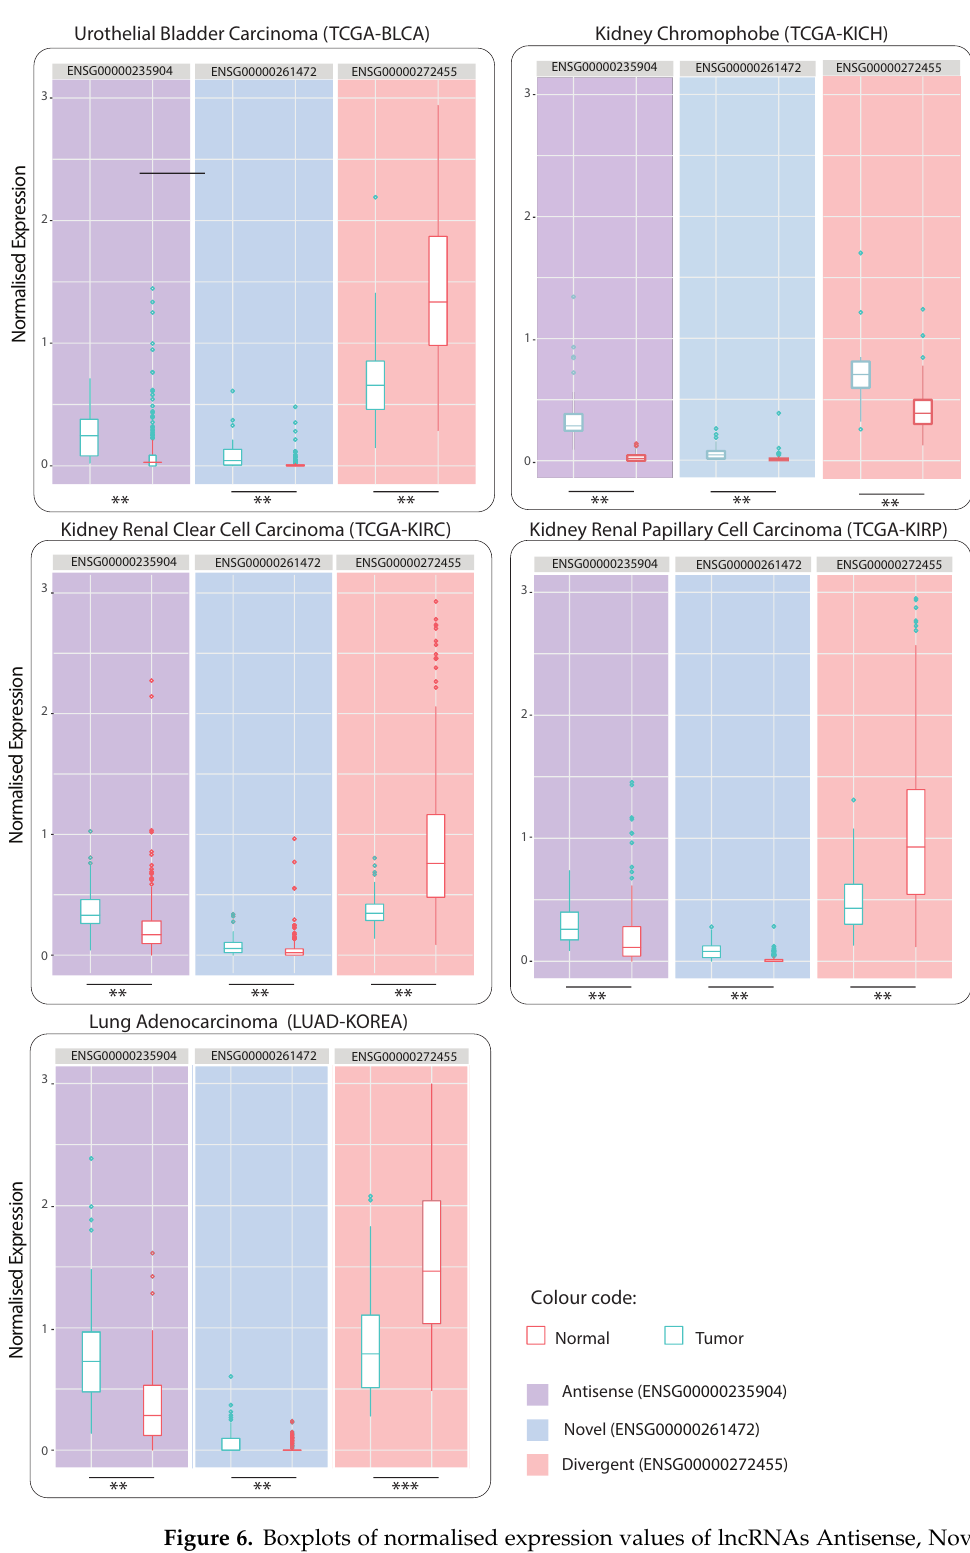
Figure 6. Boxplots of normalised expression values of lncRNAs Antisense, Novel and Divergent, in tumor versus non-neoplastic samples across five other cancer types which have not been used during the discovery phase of these lncRNAs. These include TCGA datasets, namely urothelial bladder carcinoma (BLCA), kidney chromophobe (KICH), kidney renal clear cell carcinoma (KIRC), and cervical kidney renal papillary cell carcinoma (KIRP), and one non-TCGA lung adenocarcinoma dataset collected in Seoul, South Korea (LUAD_KOREA). Significant adjusted p -values (adj p ≤ 0.01) are represented by a star, from left to right: the t -test and the Wilcoxon